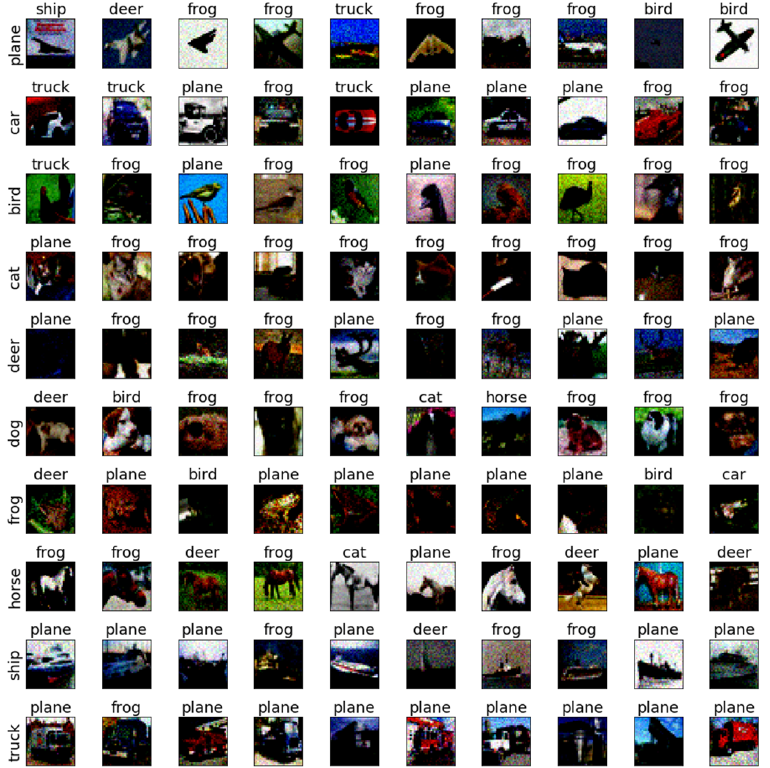
Figure 17. The adversarial examples of BMI-FGSM for Cifar10 and ResNet18.